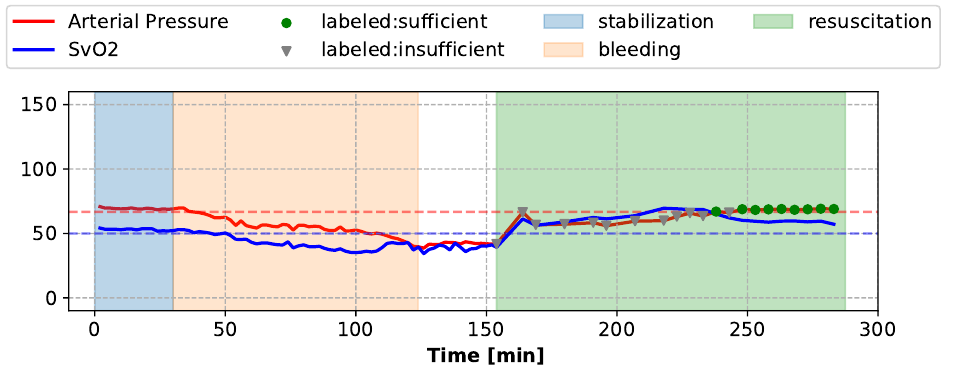
Figure 1. When the mean of Arterial Pressure and the mean of SvO2 (both invasively measured) are above the target values (dashed lines), the subject is labeled as “sufficient” at the given assessment time, or as “insufficient”